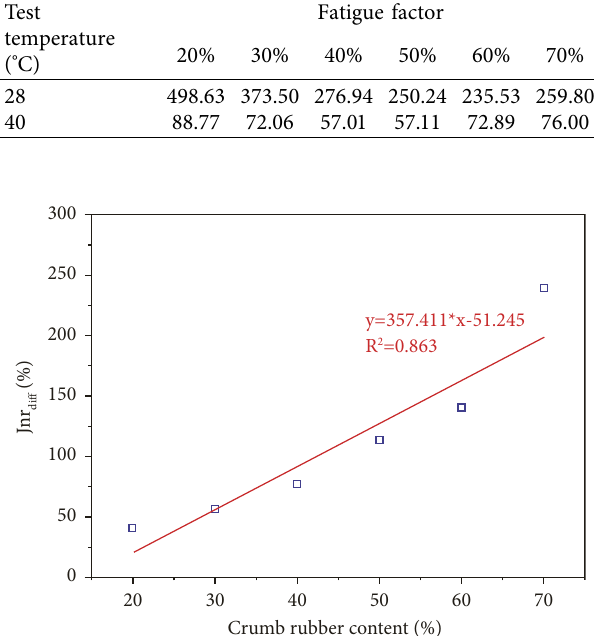
Figure 13: Effect of crumb rubber content on Jnr